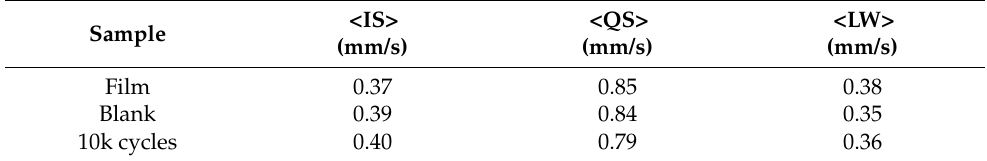
Figure 7. Room temperature Mössbauer spectra for non-cycled FWO-600 electrode (“Film”), non- cycled but soaked in electrolyte (“Blank”) and cycled electrode after 10,000 cycles at 20 mV s − 1 (“10k cycles”). Table 1. Room temperature 57 Fe Mössbauer hyperfine parameters, <IS>, <QS> and <LW> are the average isomer shifts, quadrupole splitting and linewidth